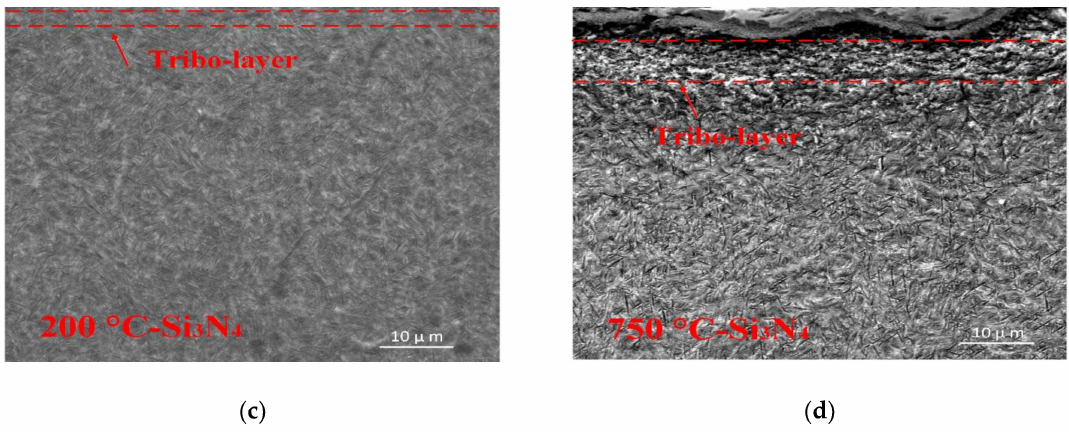
Figure 10. SEM micrographs of cross sections showing friction layer of the alloy vs. Al 2 O 3 at 200 ◦ C ( a ) and 750 ◦ C ( b ), friction layer of the alloy vs. Si 3 N 4 at 200 ◦ C ( c ) and 750 ◦ C ( d ).